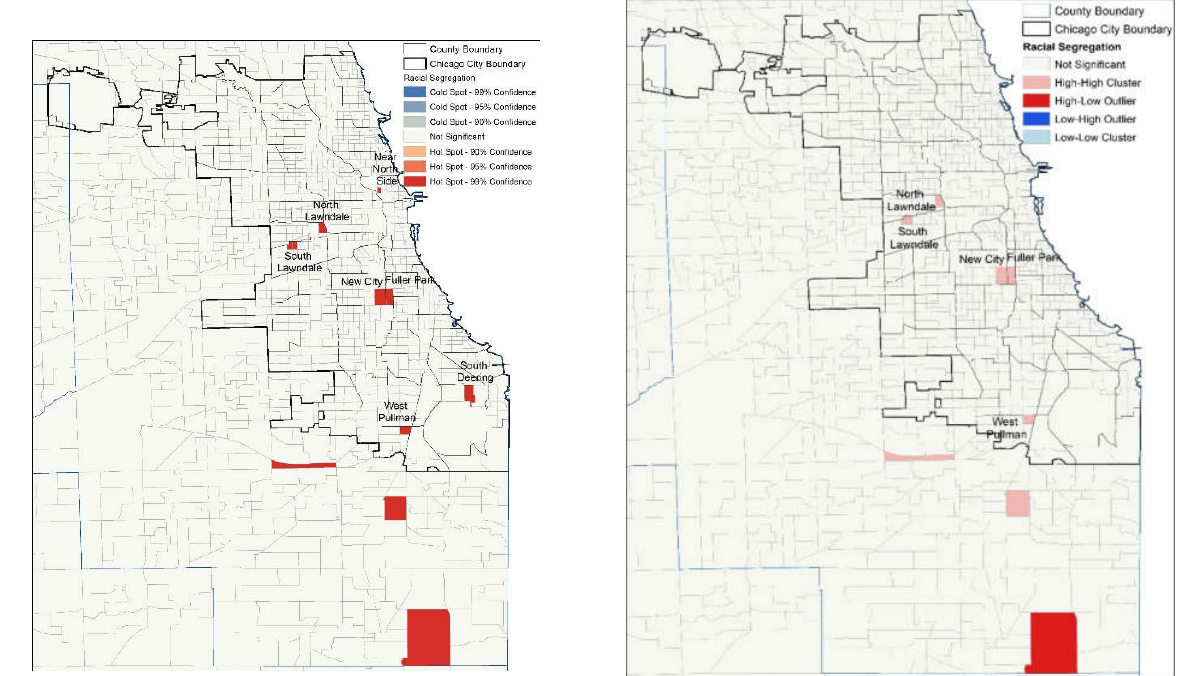
Figure 2. Clusters and outliers of racial segregation index ( left ) and hotspots of racial segregation index ( right ). Since there are no clusters, outliers, hotspots, and coldspots beyond Cook County, the map only shows the spatial extent of Cook County instead of the Chicago metropolitan area.